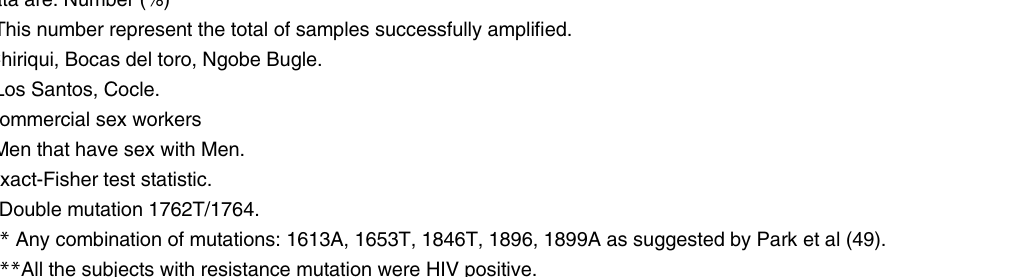
Table 1. Genotype distribution of the HBV sequences evaluated according to risk behavior group, geographic location and the mutations found in BCP, X/PreC and Polymerase.